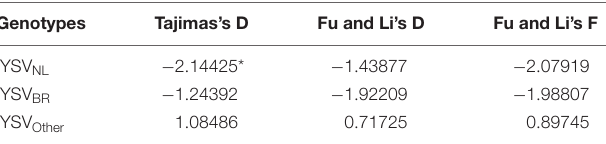
TABLE 3 | Neutrality test of Iris yellow spot orthotospovirus genotypes based on total number of mutations.